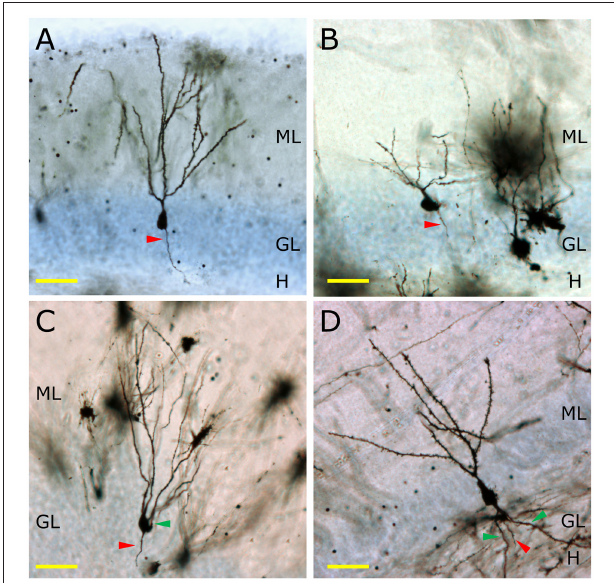
FIGURE 2 | The morphology of granule neurons among different mammalian species. In (A) the morphology of a Golgi-impregnated murine granule neuron is shown. The total lack of basal dendrites, as well as the presence of one single primary apical dendrite and one axonal process (red triangle) can be observed. In the Capuchine monkey, a great variability of morphologies is observed. A representative neuron lacking basal dendrites and having one apical dendrite and one axonal process is shown (B) . Conversely, one of the most remarkable morphological features of the granule neurons of the Chimpanzee (C) is the presence of basal dendrites (green triangle). The same feature can be observed in human granule neurons (D) , in which a profusely branched basal dendrite emerges from the bottom of the cell soma and ramifies in the hilus. H, Hilus; GL, Granule cell layer; ML, Molecular layer. Yellow scale bar: 50 µ